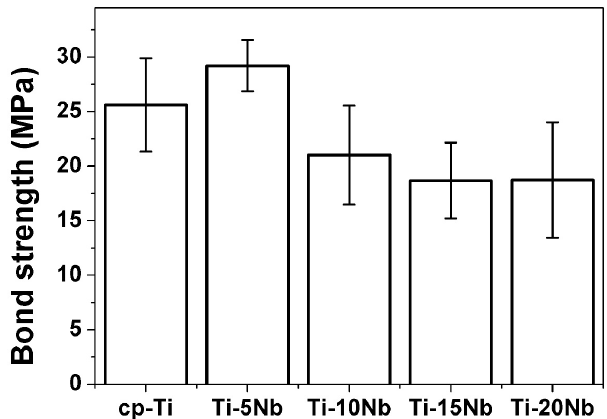
Figure 6. Bond strength of cp-Ti and Ti-xNb alloys to the ceramic ( n = 5).